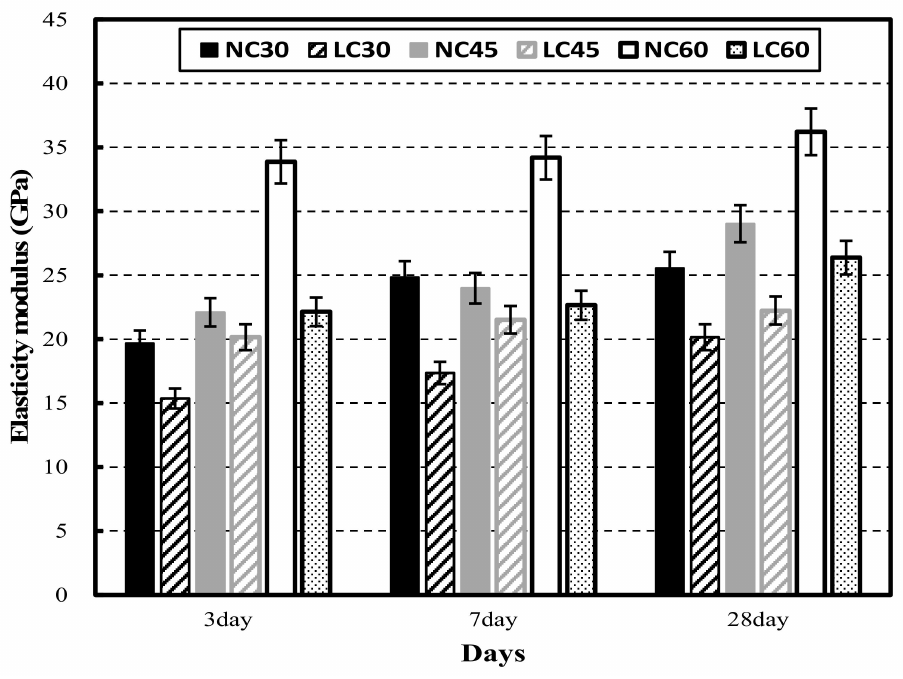
Figure 4. Elastic modulus of normal aggregate concrete and lightweight aggregate concrete at different